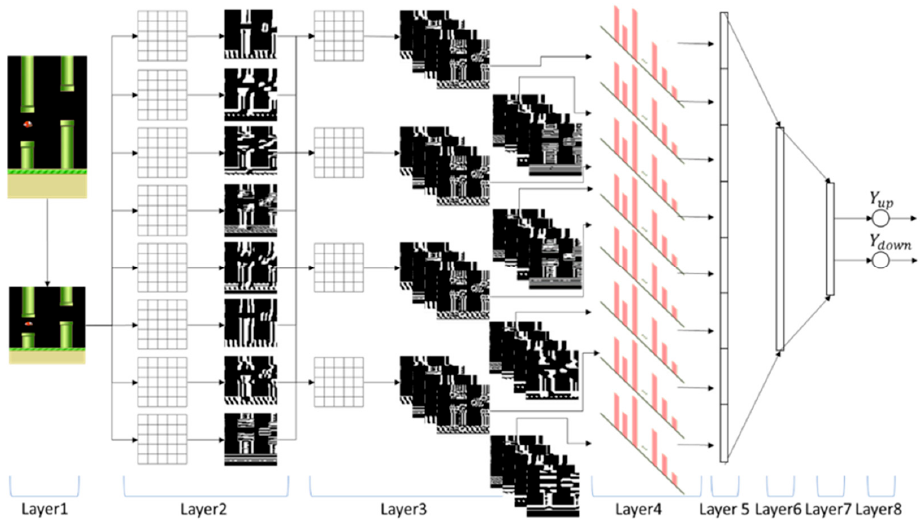
Figure 7. Diagram of the proposed DPCANet.